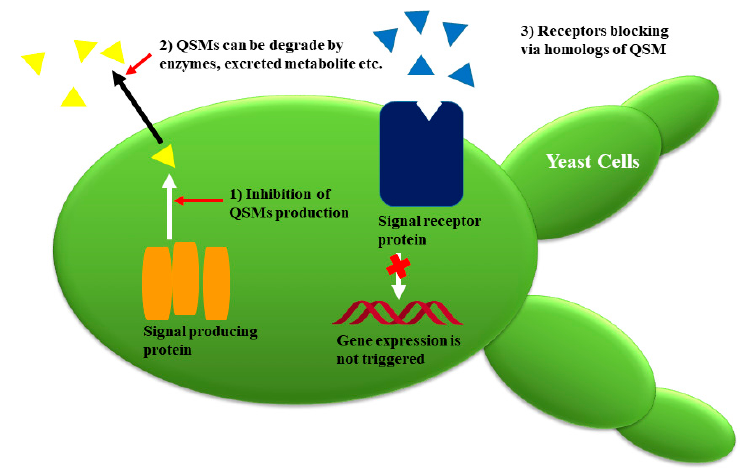
Figure 7. Strategies of fungal quorum-sensing inhibitors for tackling quorum sensing (QS) in pathogenic organisms (adapted from [3]).